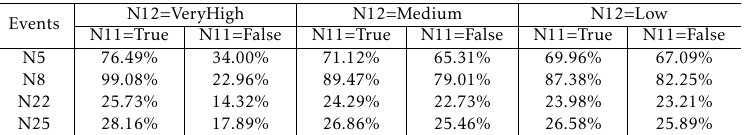
Table 8. Results of Experiment 5